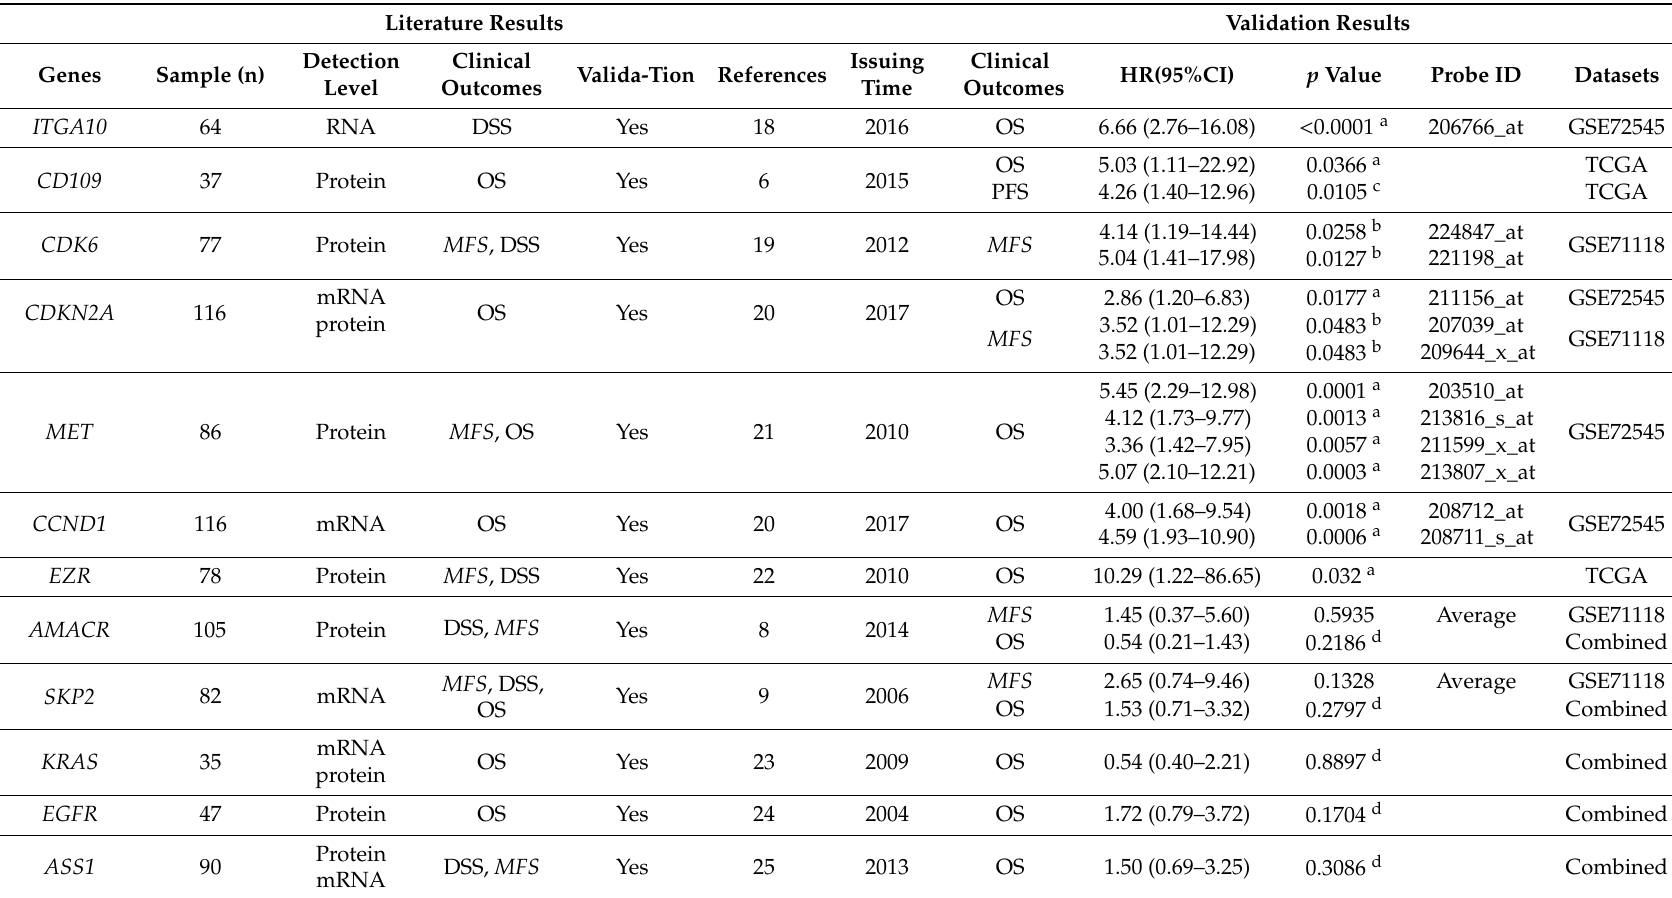
Table 2. Analysis of known prognostic biomarkers in